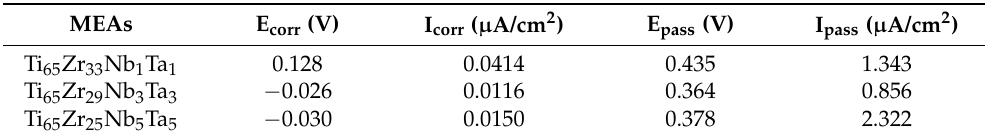
Table 4. Corrosion potential E corr , corrosion current density I corr , passivation potential E pass , and passivation current density I pass , obtained through potentiodynamic polarization tests, of Ti 65 –Zr 33